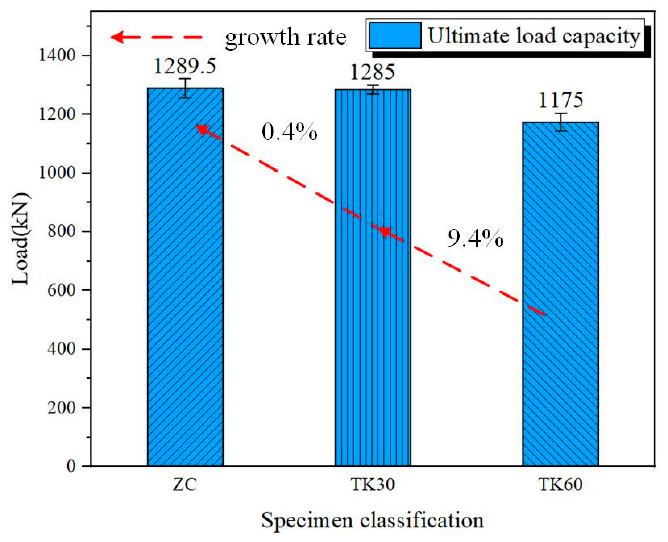
Figure 14. Comparison of ultimate shear capacity.